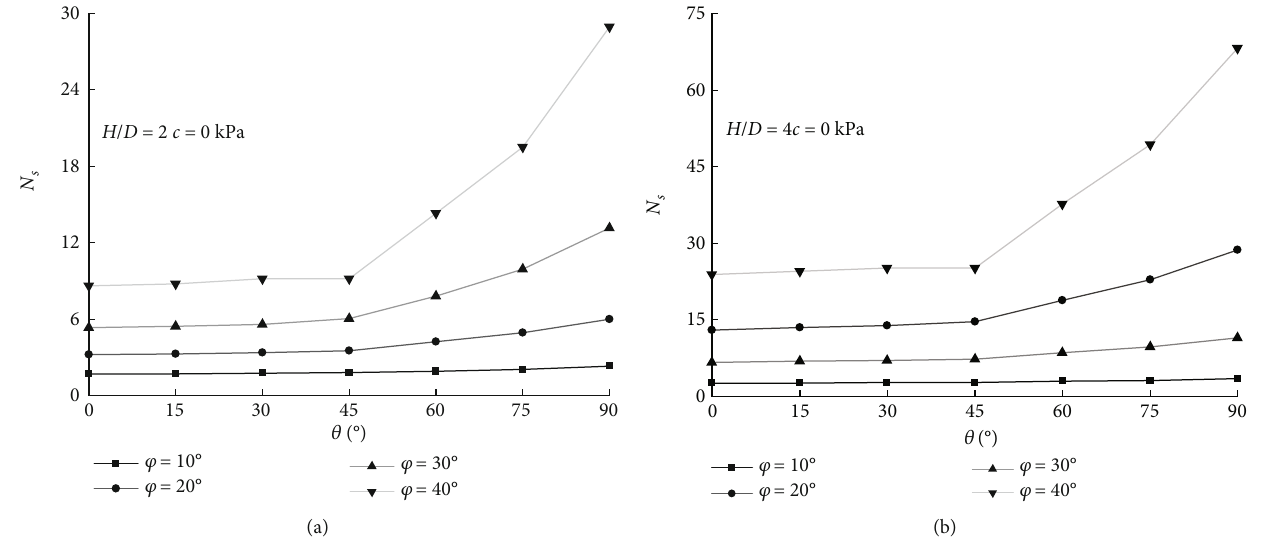
ff erent inclination angles for c = 0 kPa .